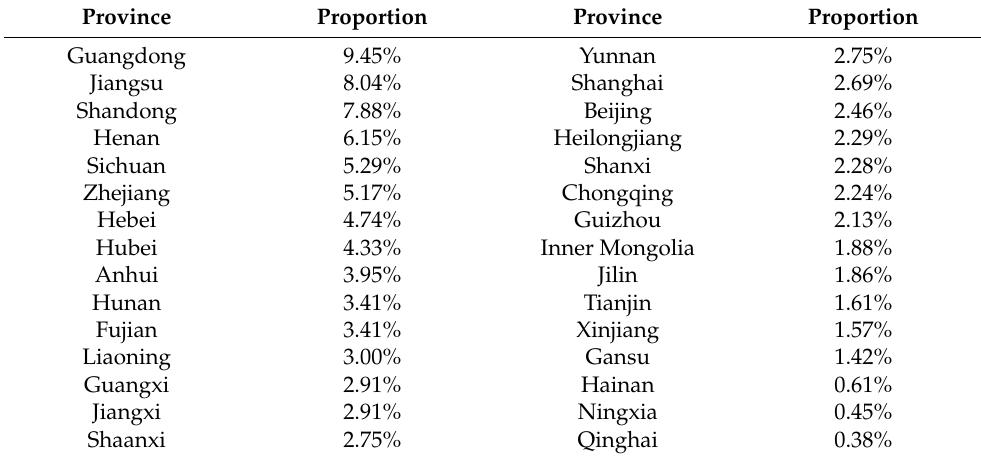
Table 5. Share of energy demand by the province in